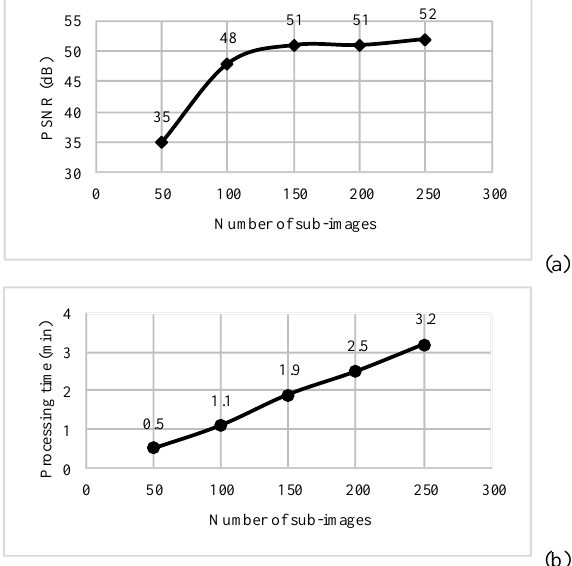
Figure 1 . The effect of the number of extracted random sub- images on (a) PSNR, and (b) processing time. Figure 2 . The effect of the size of extracted random sub-images on (a) PSNR, and (b) processing